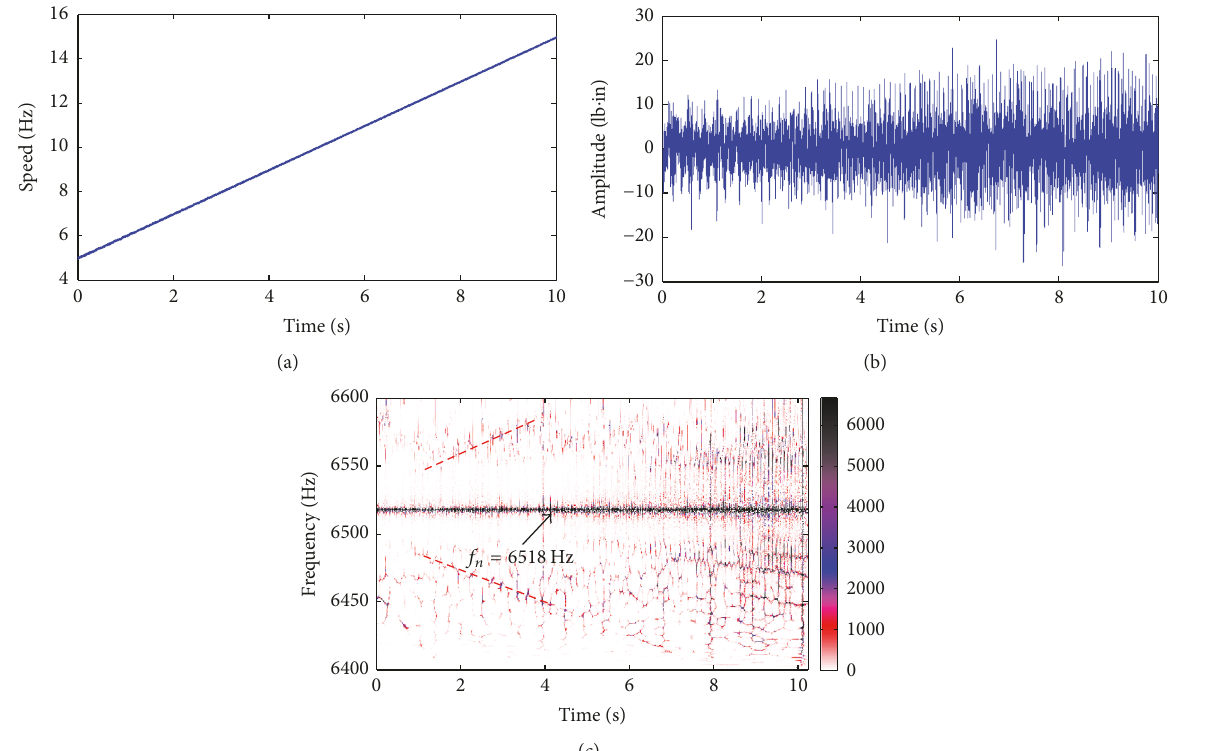
Figure 8: Resonance frequency identification: (a) drive motor speed, (b) detrended torsional vibration signal, and (c) reassigned Morlet scalogram.